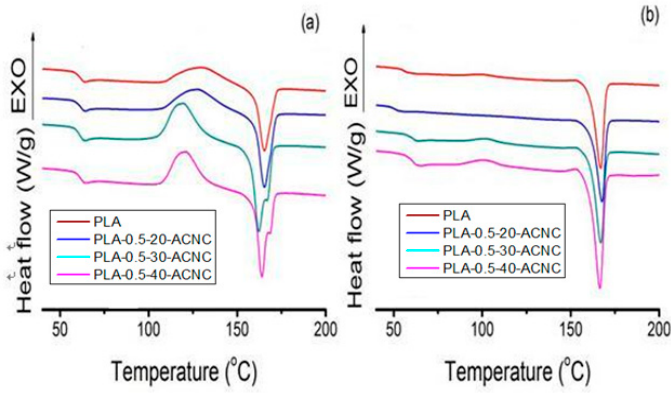
Figure 9. Differential scanning calorimeter (DSC) thermograms of PLA/ACNC composite films. ( a ) first heating scan. ( b ) second heating scan.